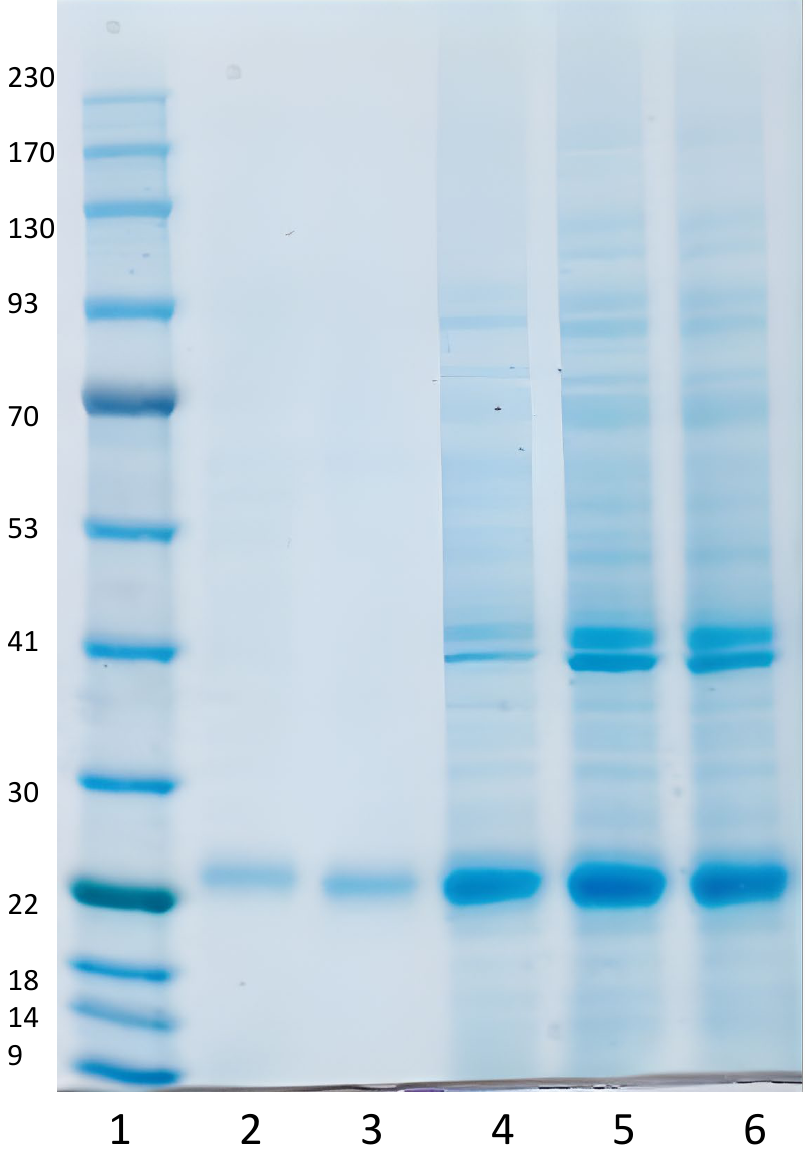
Figure 3. Time course of RBD 333–527 -C-tag vaccine subunit antigen production during the fungal C1-cell fermentation manufacturing process. Fermentation supernatant samples were analyzed in SDS-PAGE stained with Coomassie Blue. Lane 1, contains 12 different molecular weight markers, including a 22 kDa. molecular weight protein marker for reference (marked with an arrow on the left); lane 2, 29 h. of elapsed fermentation time (EFT), shows a single protein staining band at approximately 24 kDa.; lane 3, 36 h. EFT; lane 4, 60 h. EFT; lane 5, 84 h. EFT; and lane 6, 90 h. EFT.